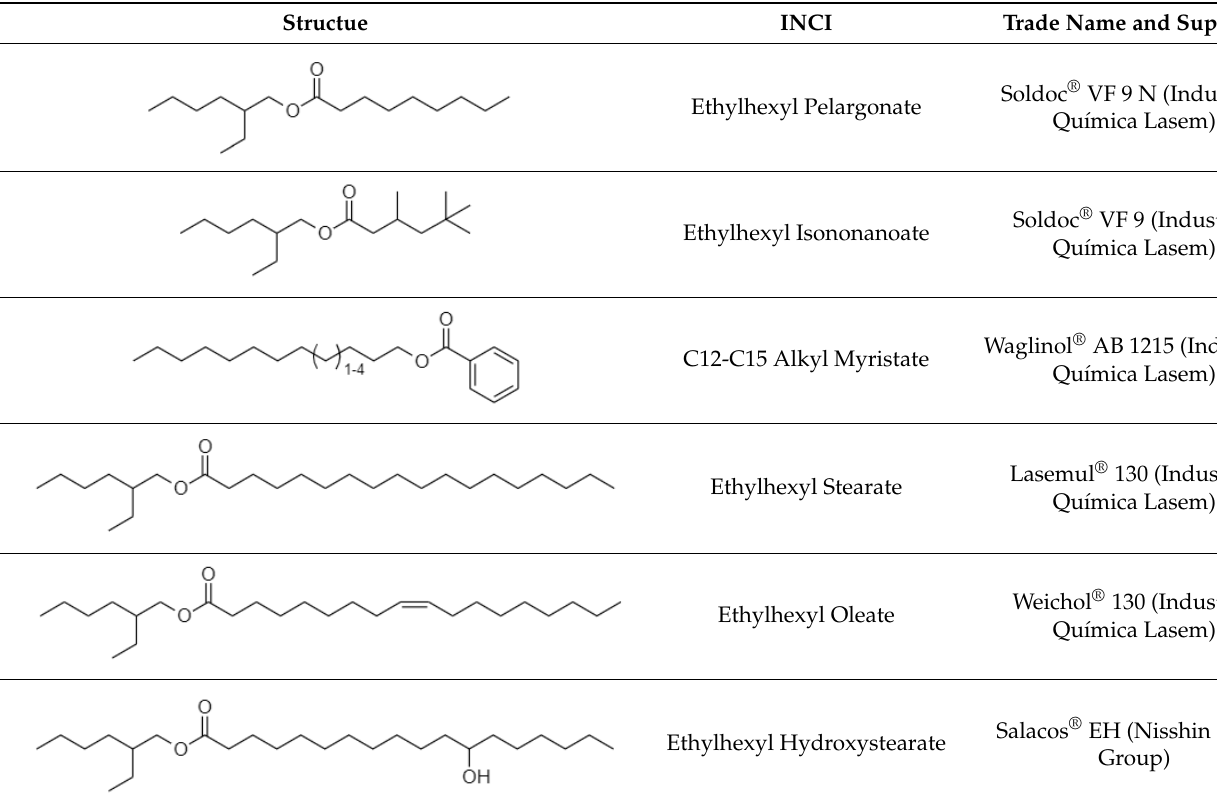
Table 1. Summary of used emollients. Structure, INCI and trade name.